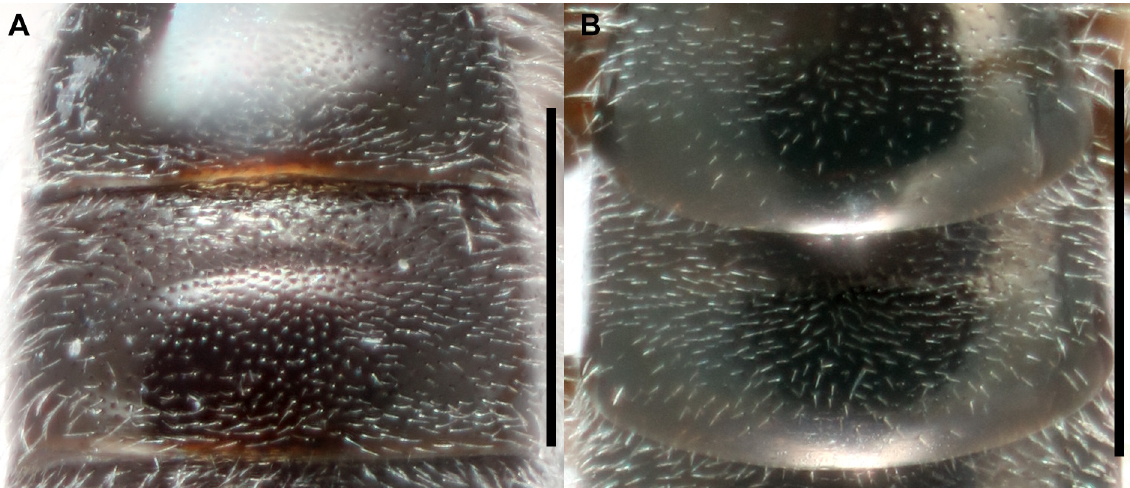
Fig. 116. T1–T2. A . Lasioglossum holzenthali sp. nov., ♂, with apical rims mostly punctate. B . L. perparvum (Ellis, 1914), ♂, with apical rims punctate only on basal margin. Scale bars = 0.5